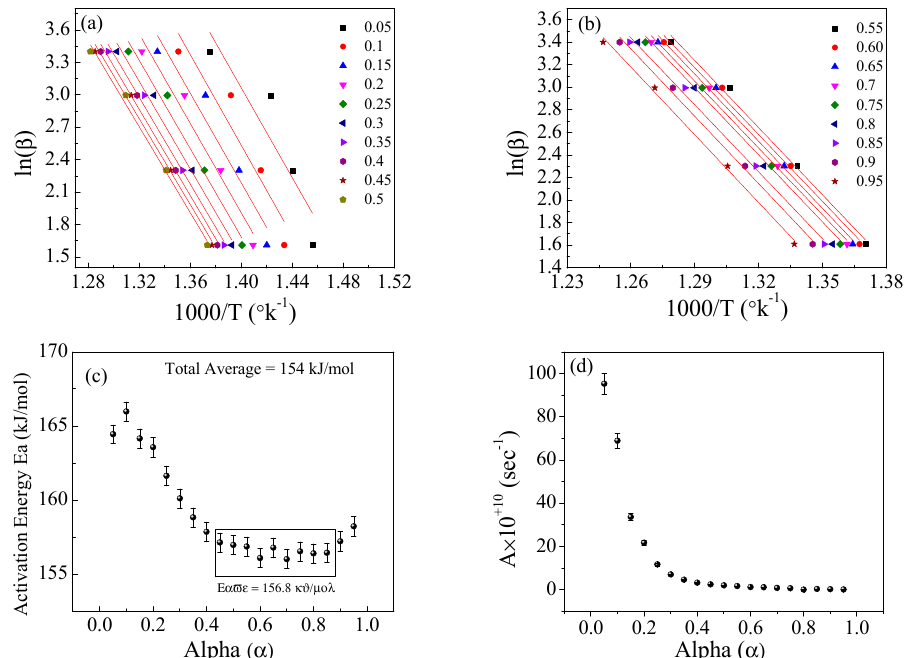
Figure 12. The Flynn–Wall − Ozawa (FWO) method for EPDM − 100 phr lead composite: ( a , b ) ln( β /T2) versus 1000/T; ( c , d ) the dependence of Ea and A, respectively, on conversion α .